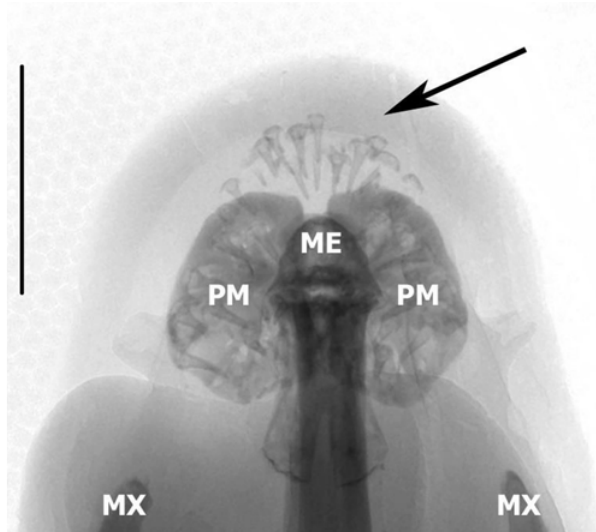
Fig. 5. Radiograph (inverted) exhibiting a dorsal view of the anteriormost region of snout of the female paratype of Tembeassu marauna (MZUSP 23090). Arrow at right indicates the patch of extra teeth at the anteriorly extended “boneless” portion of snout, loosely attached to soft tissue in front of the mesethmoid (ME) and premaxillary bones (PM) (MX = maxillary bones). Scale bar ~ 5